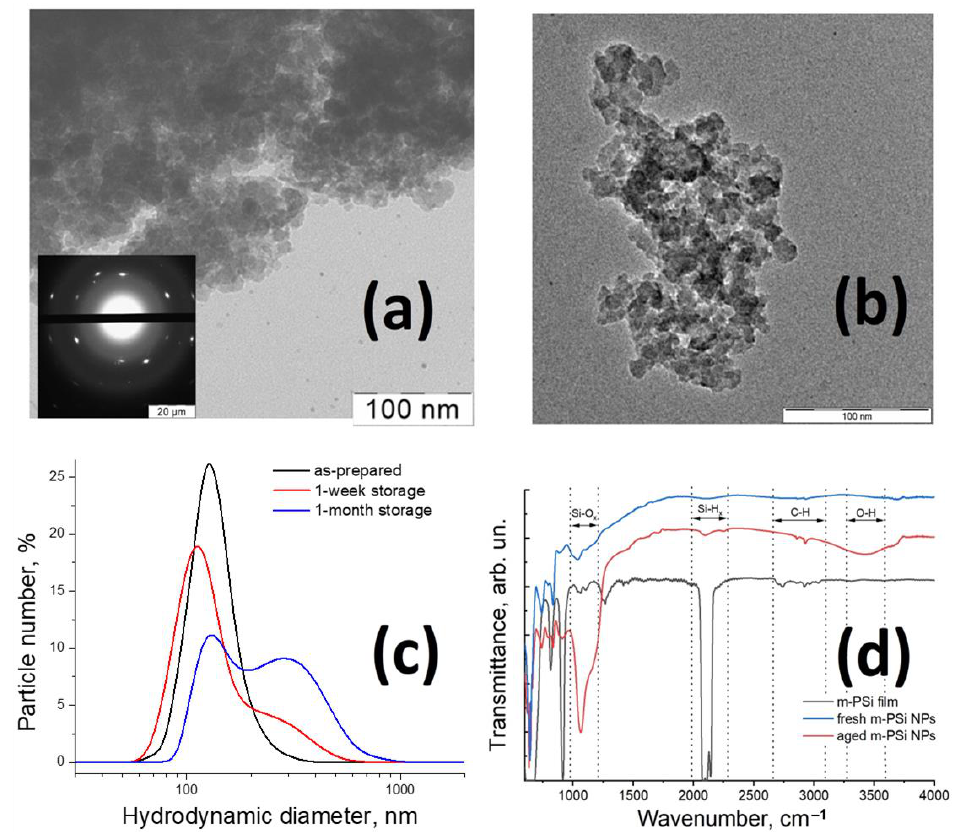
Figure 1. Characterization of the samples. ( a ) Typical TEM image and electron diffraction pattern of m-PSi NPs dried from suspension on a substrate. ( b ) High-resolution TEM image of a single particle. ( c ) DLS spectra of hydrodynamic diameter distribution of m-PSi NPs suspended in water just after their preparation ( black line ), after 1 week ( red line ), and 1 month ( blue line ) of storage at room temperature. ( d ) FTIR transmittance spectra of an m-PSi film ( black line ), m-PSi NPs dried from a freshly prepared suspension ( blue line ) and from a suspension aged for several weeks ( red line ). Black arrows and designations correspond to the bands of the main chemical groups.